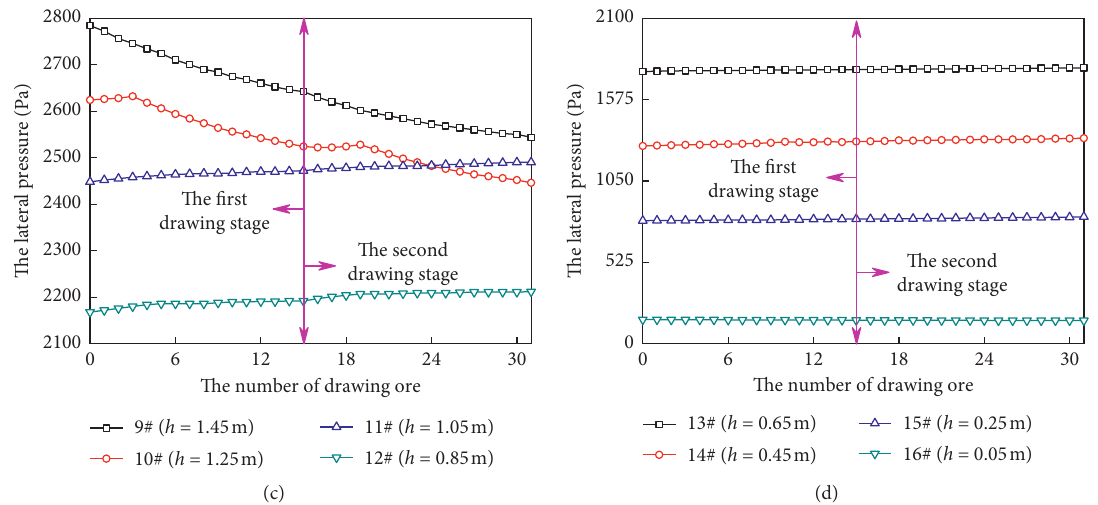
Figure 7: The relationship between the number of drawing ore and the values of lateral pressure with scheme 4.